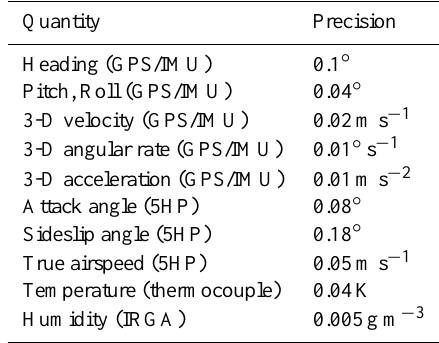
Table 1. Measurement precision of global positioning sys- tem/inertial measurement unit (GPS/IMU), five-hole probe (5HP), thermocouple, and infrared gas analyzer